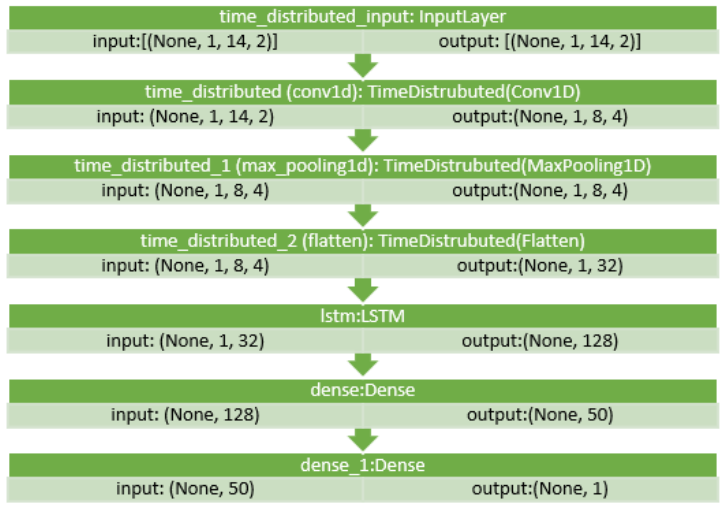
Figure 11. CNN – LSTM layers for the seventh iteration with (d0, o1) for the Beijing dataset.